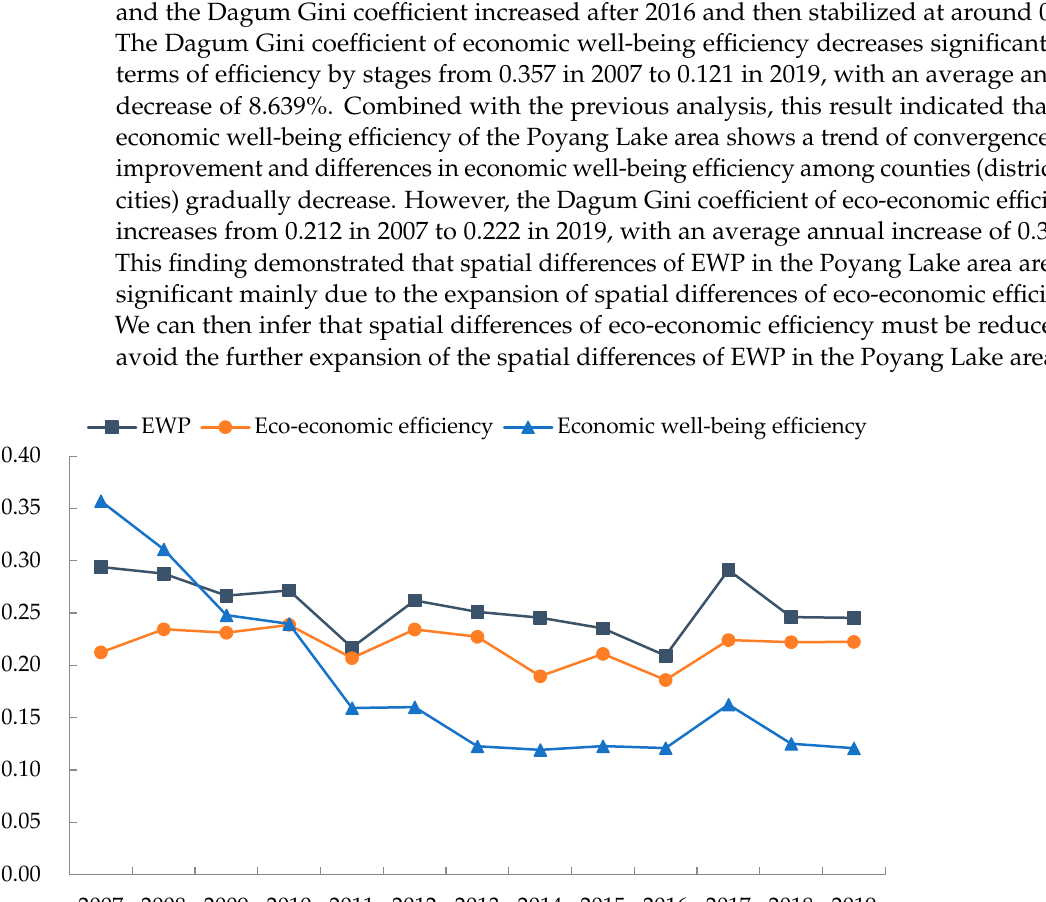
Table 5. Spatial differences decomposition of EWP in the Poyang Lake area from 2007 to 2019.